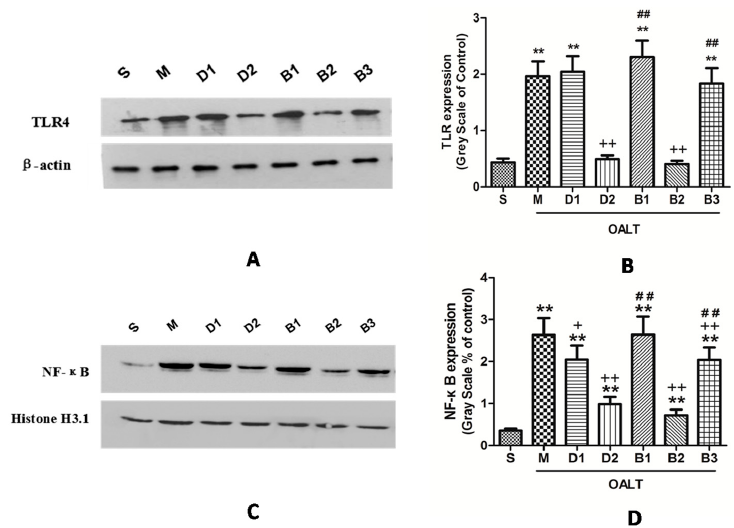
Figure 4. Expression of the Toll-Like Receptor 4 (TLR4) and NF- κ B proteins in liver tissue of the different groups. ( A ) representative Western blotting for TLR4 in total proteins; ( B ) quantification analysis of TLR4 protein expressions by reference to β -actin content; ( C ) representative Western blotting for NF- κ B p65 in nuclear proteins; and ( D ) quantification analysis of NF- κ B p65 protein expressions by reference to Histone H3.1 content. The data are expressed as the means ± SD ( n = 5–7). ** p < 0.01, vs. group S; + p < 0.05, ++ p < 0.01, vs. group M; ## p < 0.01, vs. group D2.